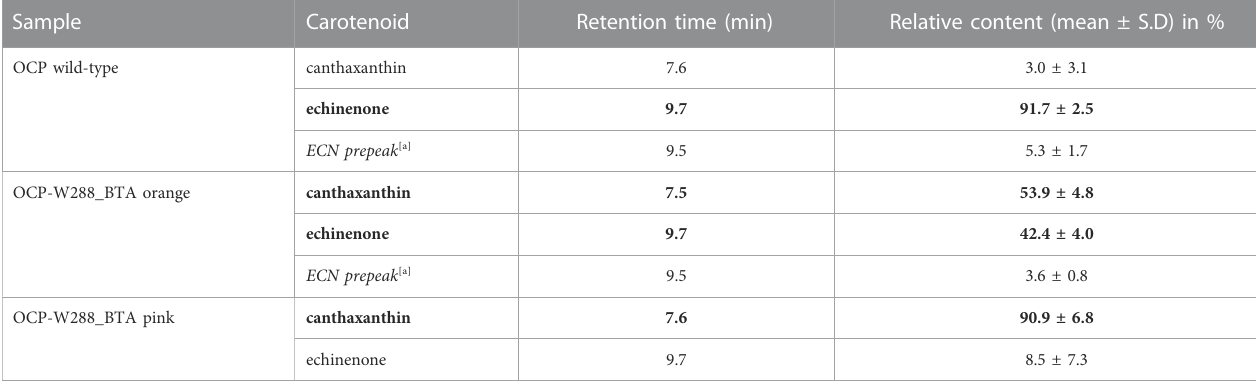
TABLE 1 Carotenoid content determined by HPLC (see chromatograms in Supplementary Figure S1). Sample